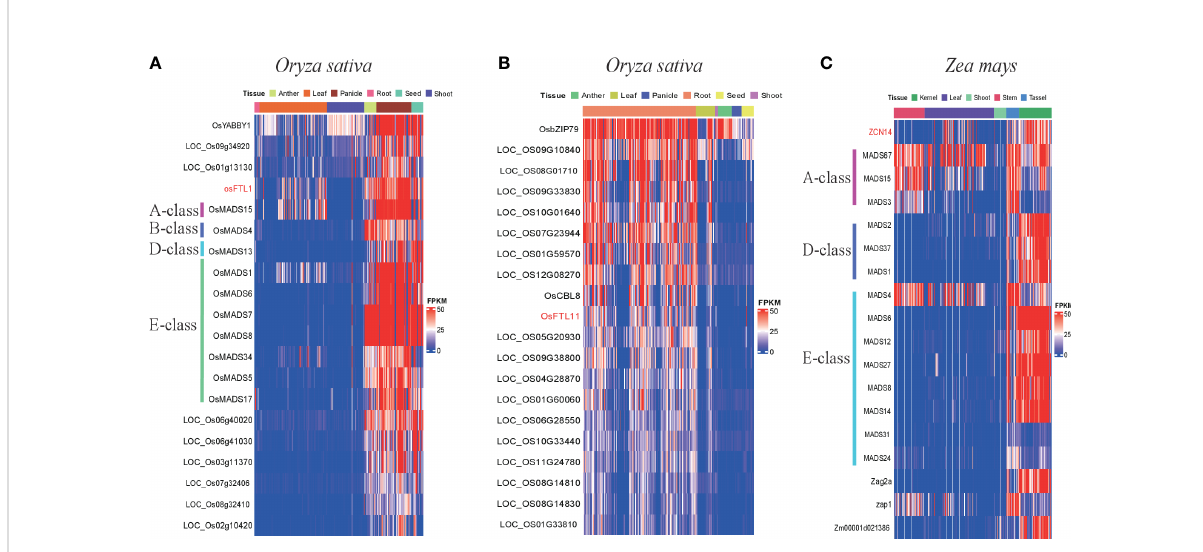
FIGURE 7 Expression patterns of FT and their co-expression genes in Oryza sativa and Zea mays . (A) Expression patterns of OsFTL1 and its co-expression genes in anther, leaf, panicle, root, seed, and shoot; different MADS-box classes labeled in different color lines. (B) Expression patterns of osFTL 11 and its co-expression genes in anther, leaf, panicle, root, seed and shoot; different MADS-box class labeled in different color line. (C) Expression patterns of ZCN14 and its co-expression genes in kernel, leaf, shoot, stem, and tassel; different MADS-box classes labeled in different color